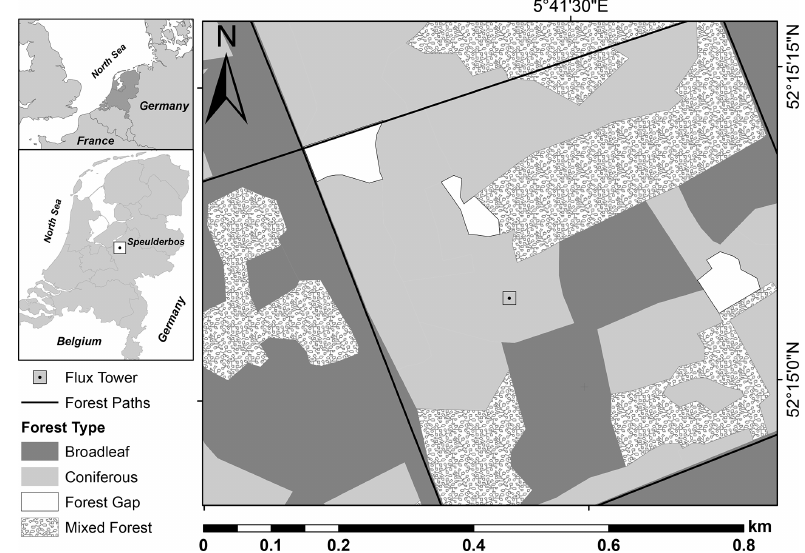
Figure 1. Forest type distribution around the tower site at the Speulderbos forest, the Netherlands.